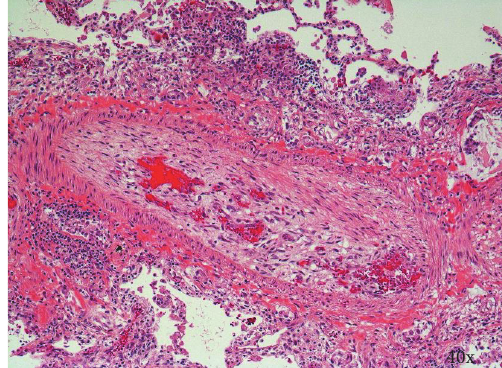
Figure 4: Section showing thrombosed medium-sized pulmonary artery with recanalization. Various stages of thrombosis were observed in many arteries throughout all lobes. Hematoxylin and